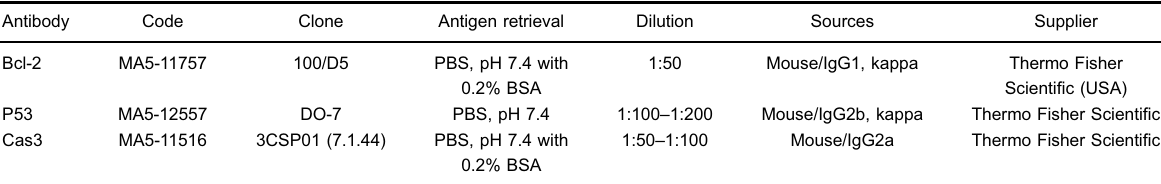
Table 1. Antibodies used for immunohistochemical